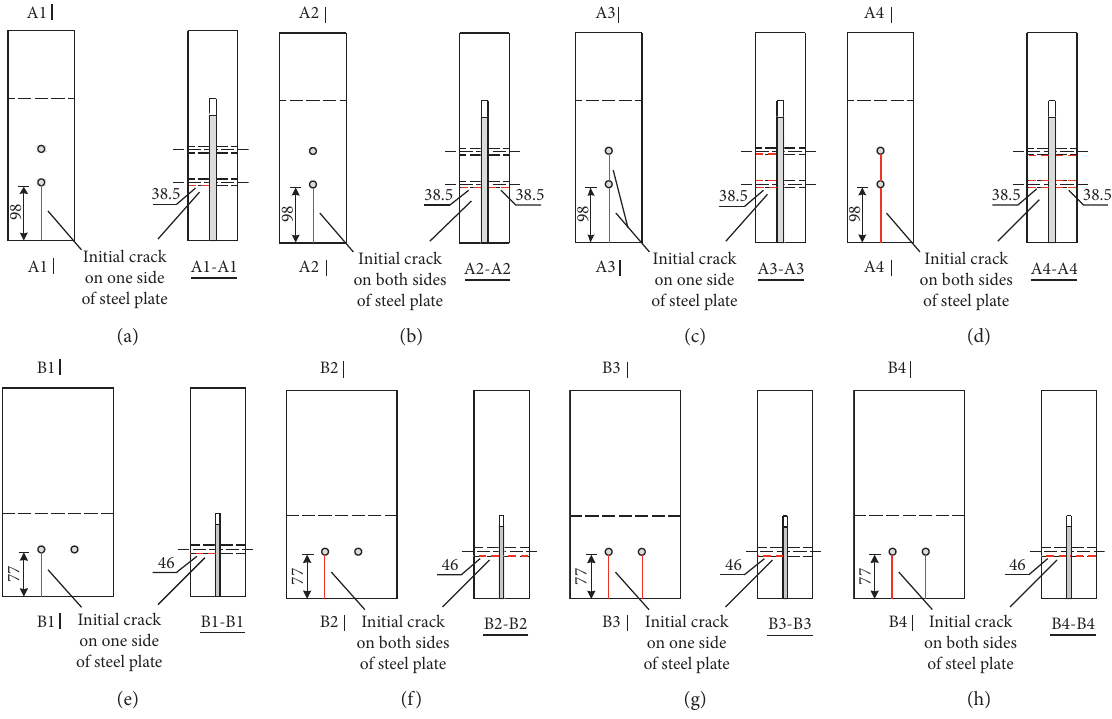
Figure 11: Different crack patterns considered in Joint 1 and Joint 2. (a) Joint 1-SB. (b) Joint 1-DB. (c) Joint 1-ST. (d) Joint 1-DT. (e) Joint 2-LS. (f) Joint 2-LD. (g) Joint 2-RLS. (h) Joint